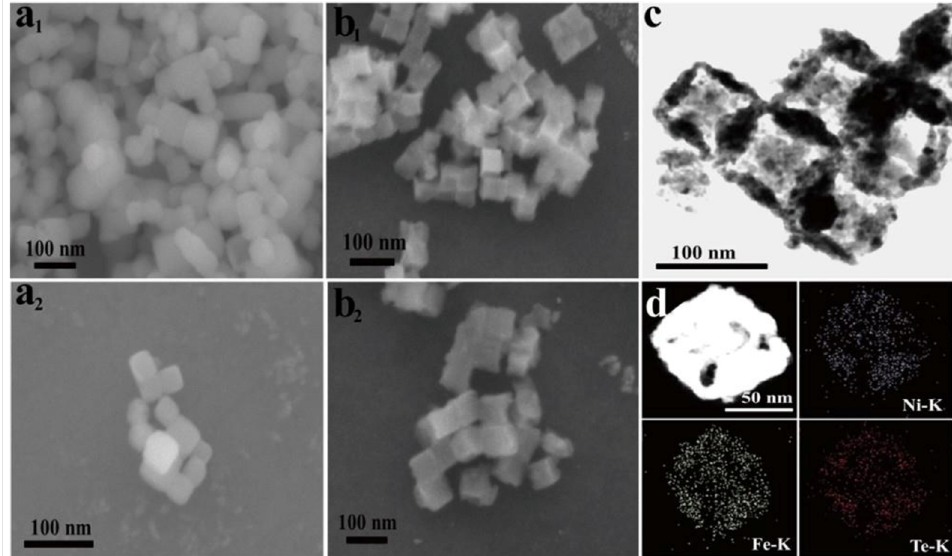
Figure 5. FESEM images of FeNiOOH-NCs and Te/FeNiOOH-NCs catalysts are represented in ( a 1 , a 2 ), ( b 1 , b 2 ), respectively; ( c ) TEM image of catalyst (Te/FeNiOOH-NC); ( d ) high-angle annular dark-field STEM image (Te/FeNiOOH-NC) and consistent elemental mapping images of Te, Ni, and Fe EDX. These figures were reprinted from